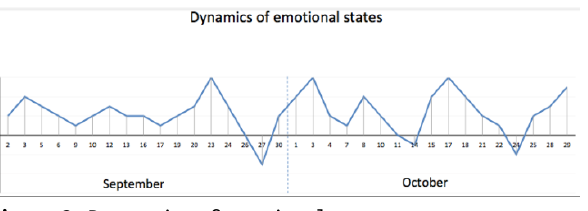
Figure 2: Dynamics of emotional